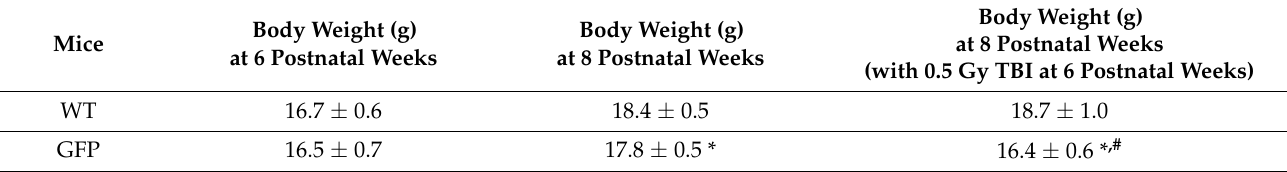
Table 1. Body weight and number of hematopoietic cells. Body Weight Mice